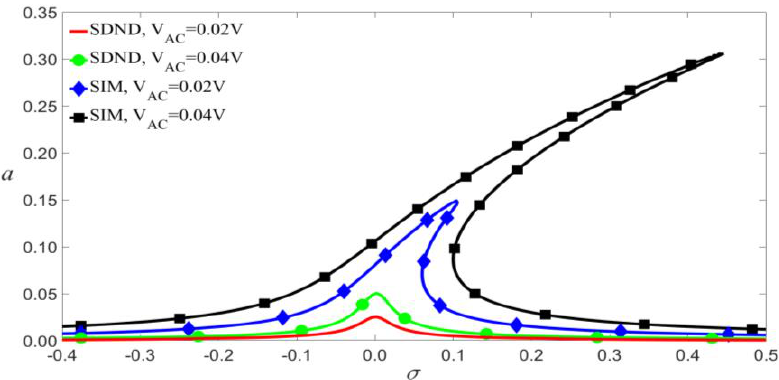
Figure 8. Frequency-response curves of primary resonance for V DC = 4 V and P 0 = 0.01 N.